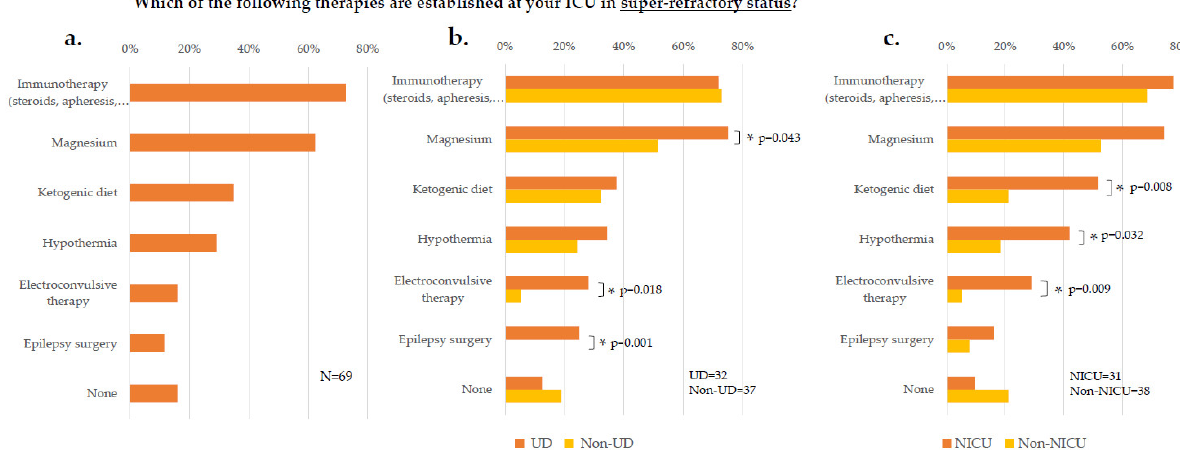
Figure 5. Further therapies in super-refractory status. Answered by all participants ( a ), among levels of care ( b ), and among specialties ( c ). Data are displayed as percentage of survey participants answering this question. N number of respondents, UD = university department; NICU = neurological/ neurosurgical ICU; ICU = intensive care unit; * = significant; p -values were determined by Chi-square test or Fisher’s exact test.